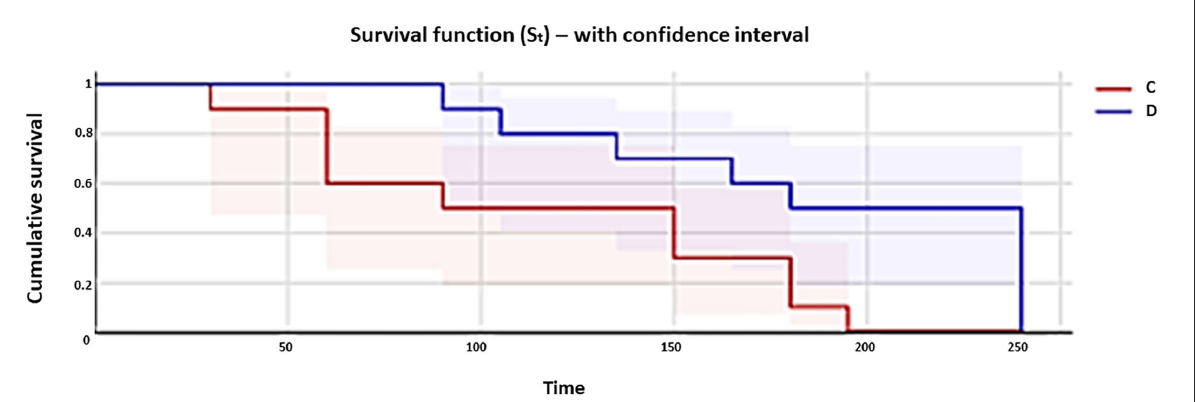
FIGURE2 Kaplan–Meier curves show the percentage of rescue analgesia requirement (0.2 mg/kg of methadone administered intramuscularly with 1 mg/kg of subcutaneous robenacoxib) in dogs of group C (red line) and group D (blue line) during the 4h after extubation. Curves are reported in